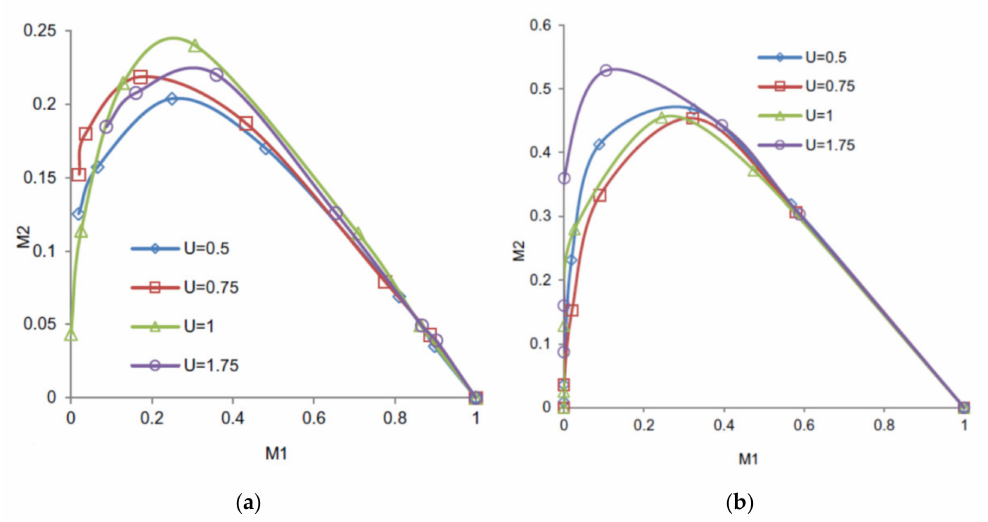
Figure 9. Grinding profiles for the gold ore at different U values for ( a ) finer feed and ( b ) coarser feed